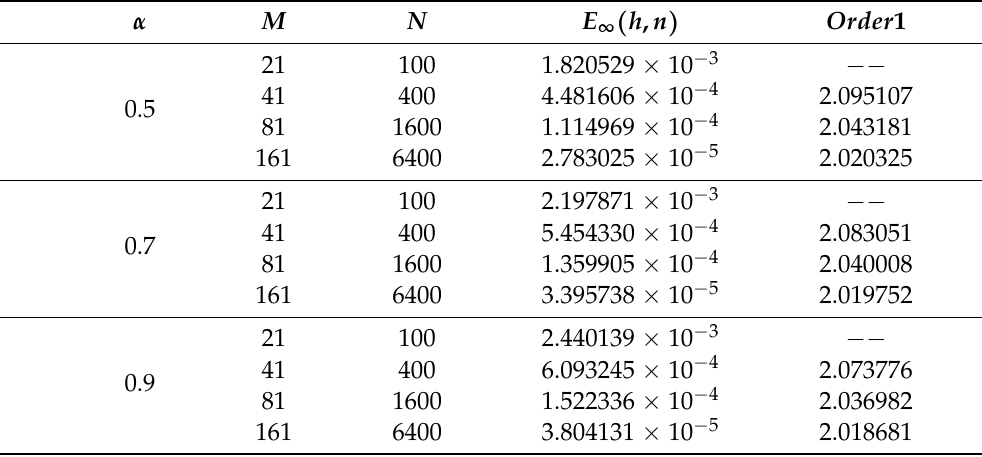
Table 5. Numerical error and spatial convergence of HASC-N difference scheme for Example 2.